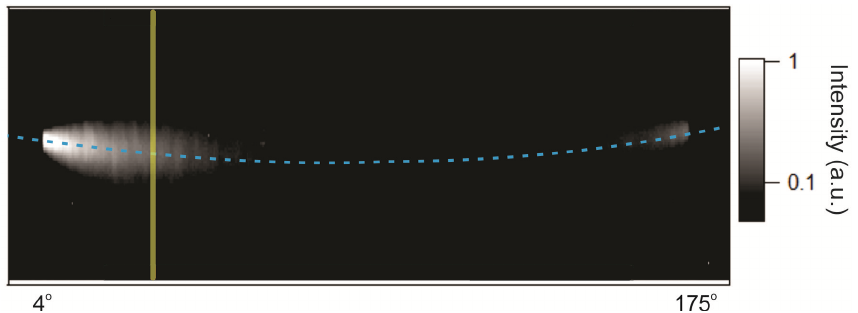
Figure 2. Example raw CCD image during Fire A for the 405nm laser. The yellow rectangle indicates the direction across which the image is integrated in order to determine scattering for a single angle bin ( ∼ 0.5 ◦ ). The image represents 100 × 400 pixel bins (transverse × parallel to laser beam). The blue dashed line shows the center of the laser beam; the slight curvature arises from the wide-angle lens being slightly off-center relative to the laser